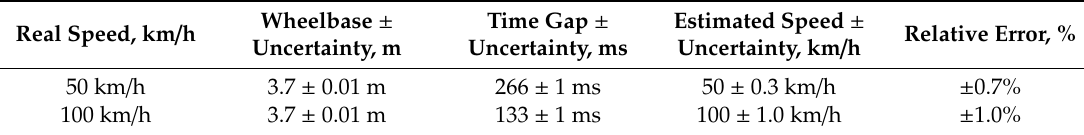
Table 1. Uncertainty estimation of the reference system.